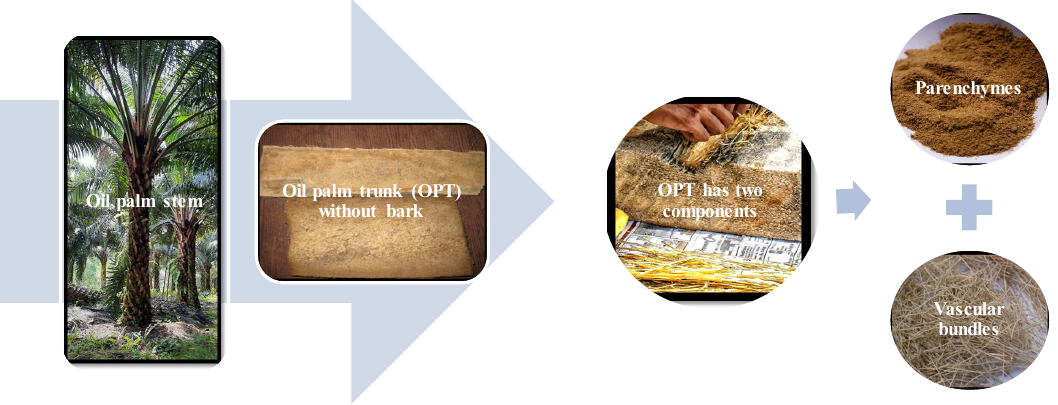
Figure 5. Two main parts of an oil palm trunk (OPT). For optimization, between the parenchyma and vascular bundles have been separated.